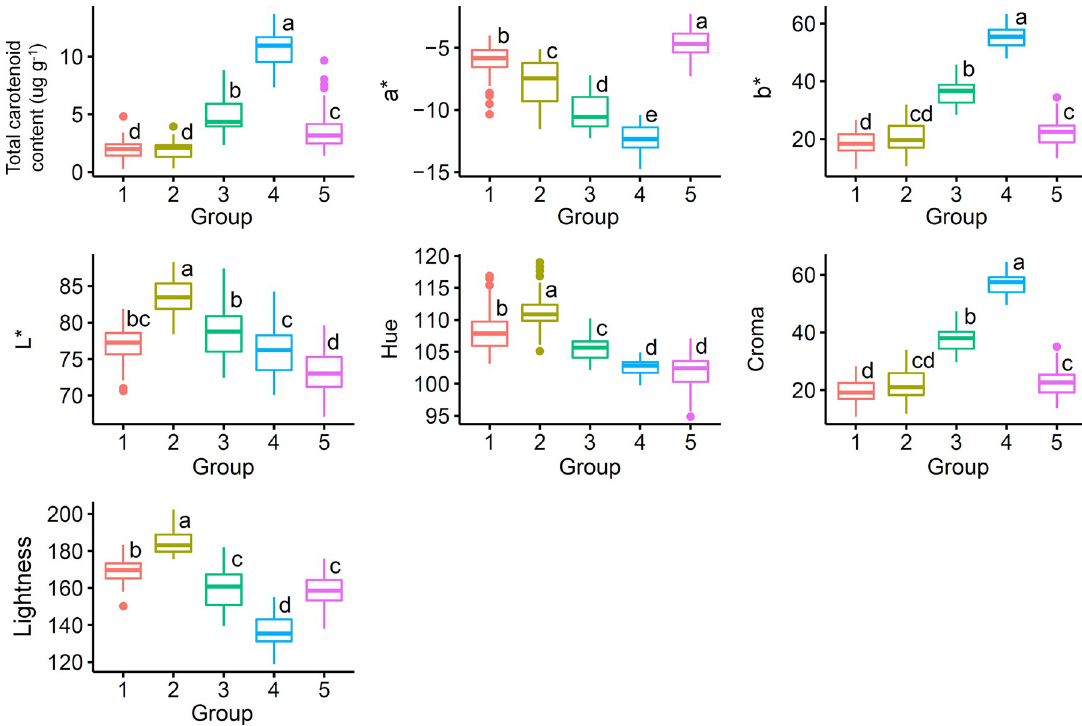
Fig 4. Boxplot of total carotenoid content and colorimetric indices for each cluster of 228 biofortified cassava genotypes based on principal component analysis. Different letters represent significant differences between accession groups with p < 0.05 by the Tukey Honest Significant Difference